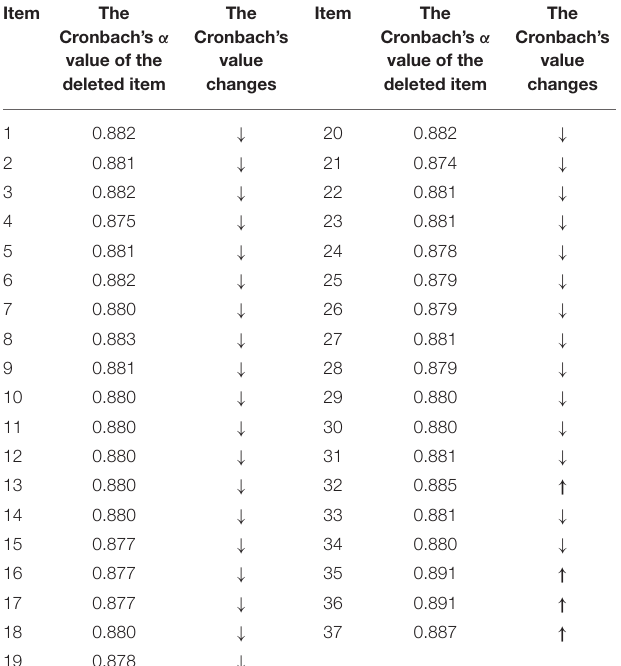
TABLE 5 | Cronbach’s coefficient and change of scale ( N =